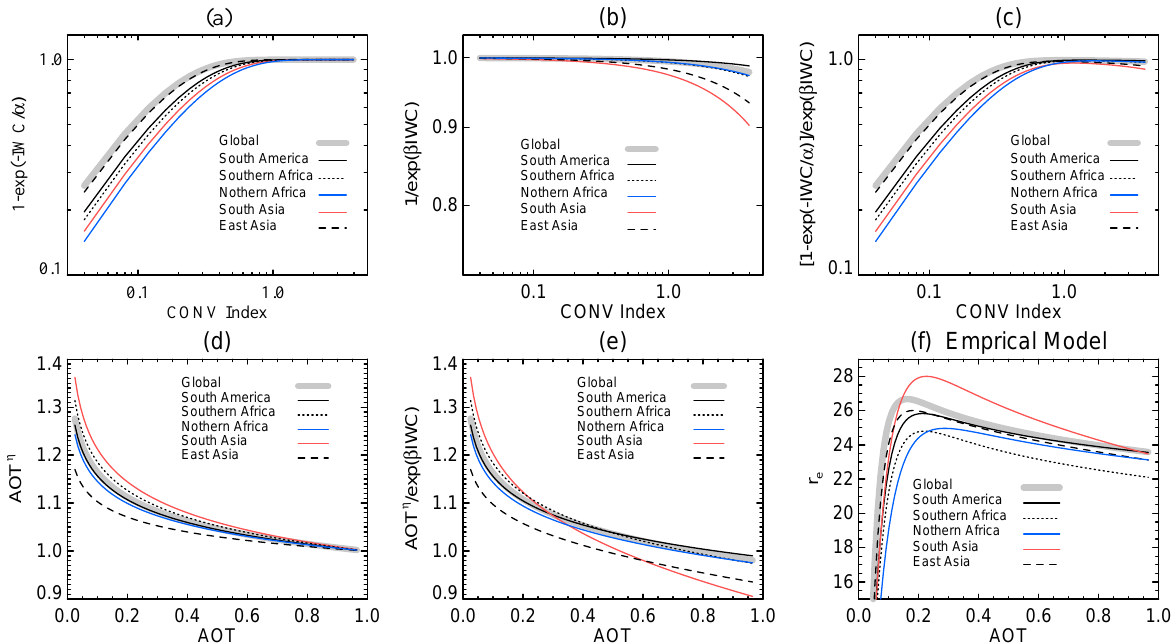
Fig. 4. (a–e) : Plots showing how each term (or the combination of two terms) of the empirical models governs r e in various regions. (f) : The modeled r e as a function of AOT for each